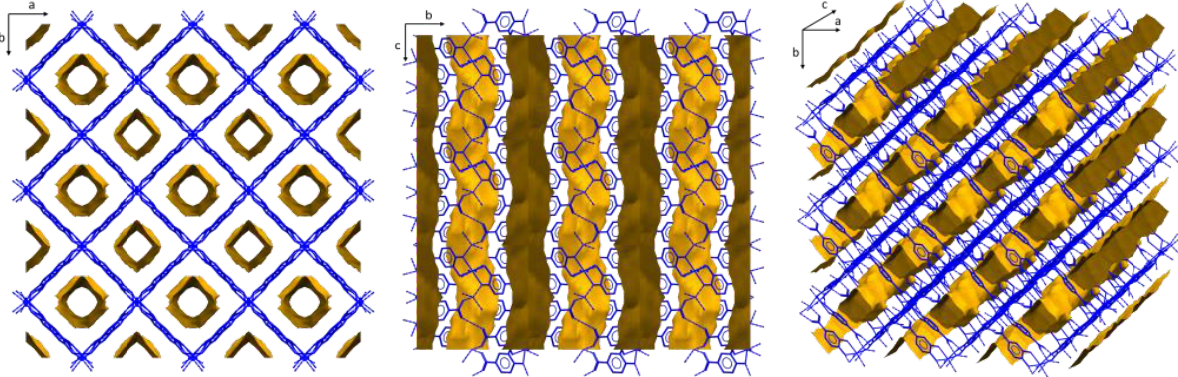
Figure 2. View of the packing of Co-MOF showing the solvent-accessible voids.